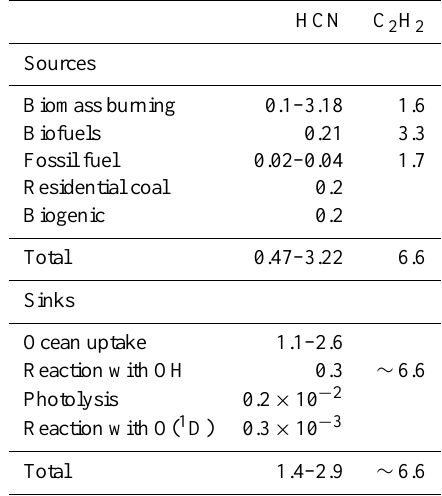
Table 1. Global HCN and C 2 H 2 sources and sinks (Tgyr − 1